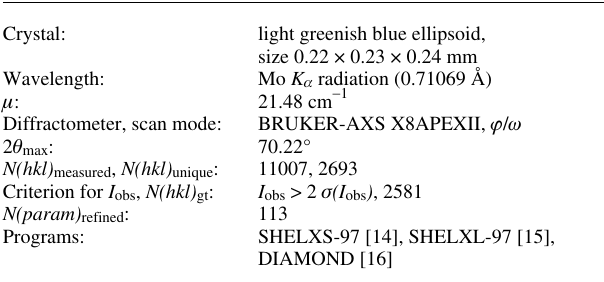
Table 1. Data collection and handling.